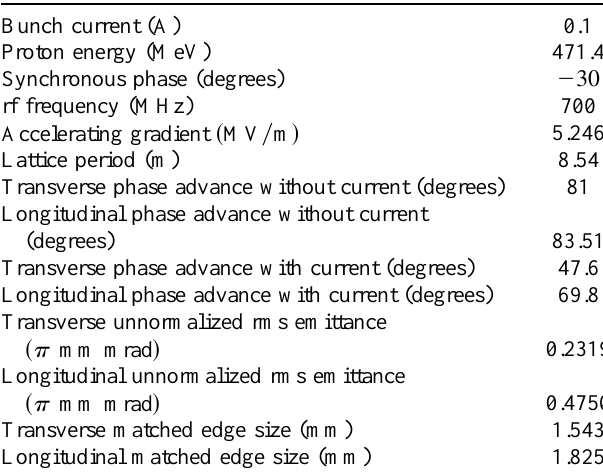
TABLE I. Physical parameters in the test example. Bunch current (A) 0.1 Proton energy (MeV)